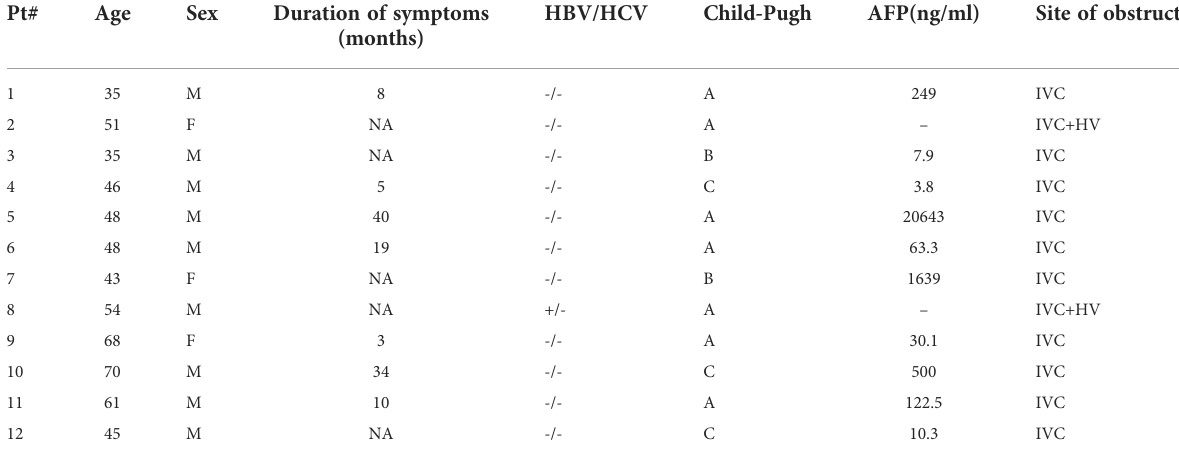
TABLE 3 Clinical features of 12 HCC patients associated with BCS.